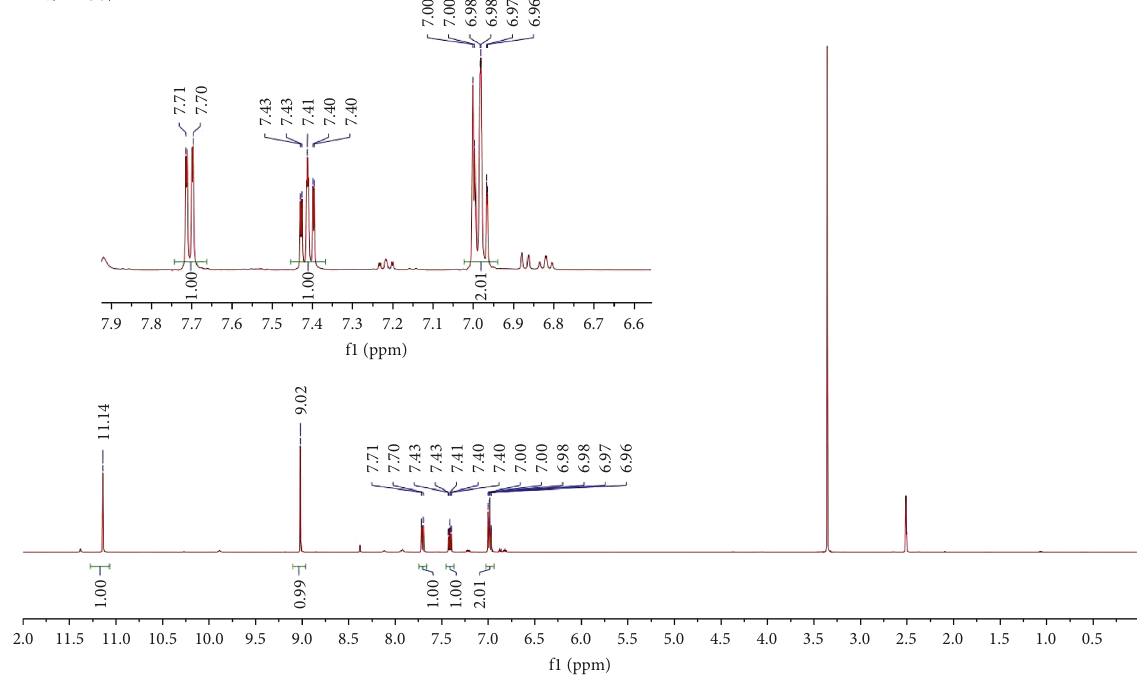
Figure 3: 1 H NMR spectrum of the ligand HLa.